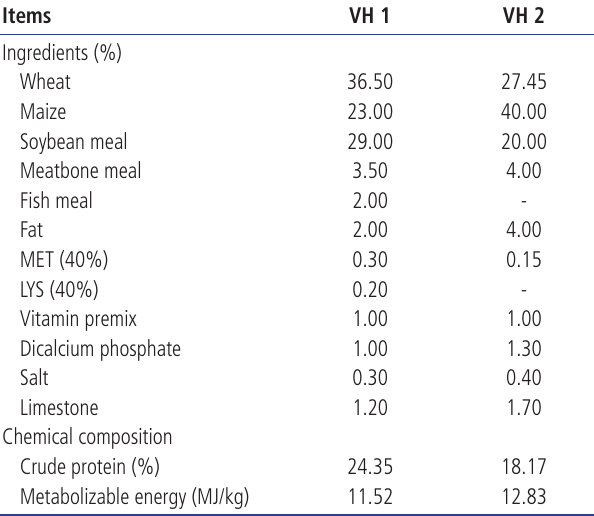
Table 1. Ingredients and chemical compositions of the feed